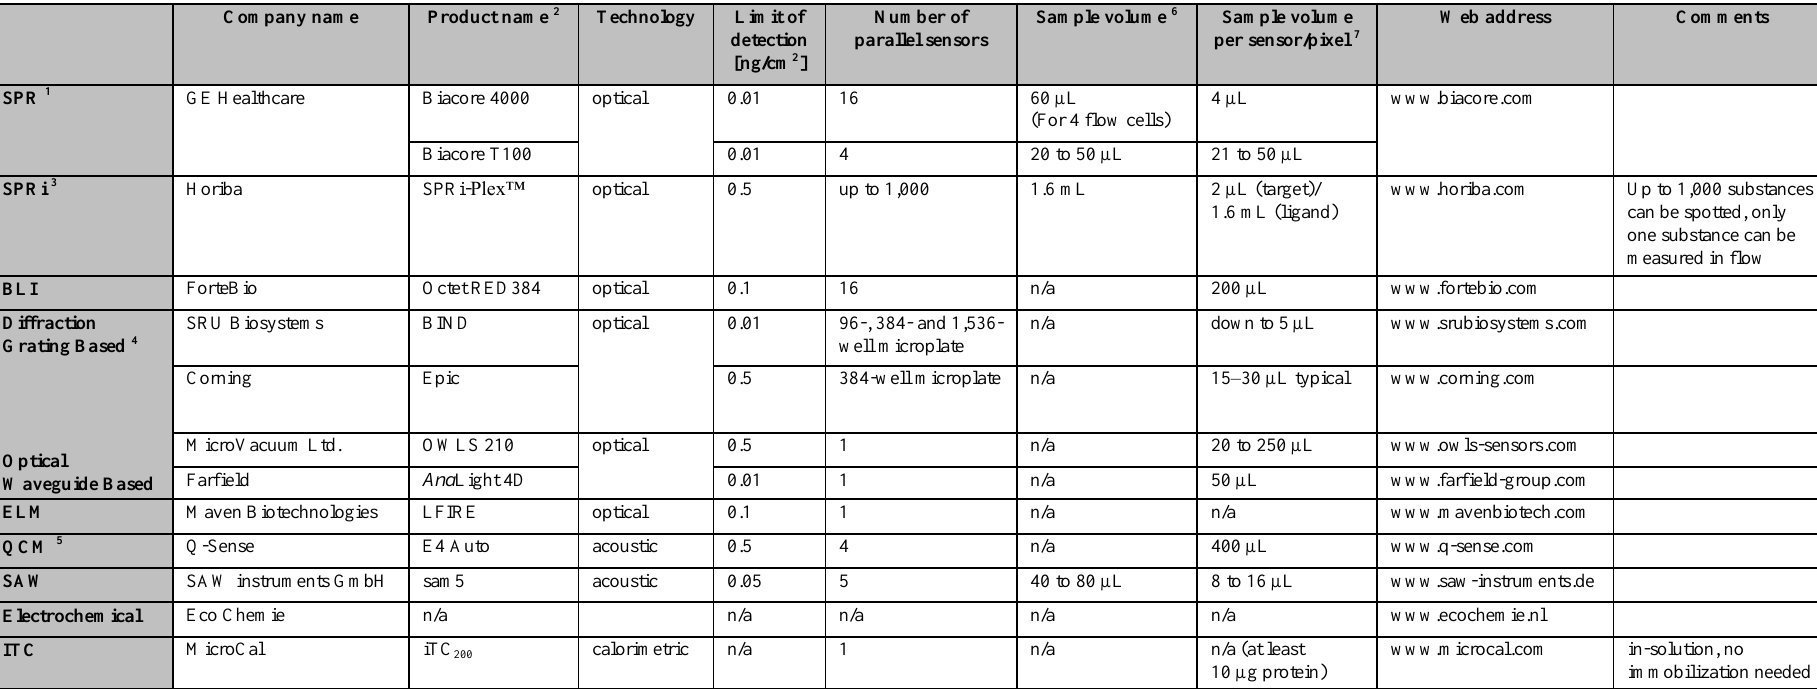
Table 1. Overview of the commercially transducer systems for Biomolecular interaction analysis (BIA). Information is taken from the website of the companies where not stated